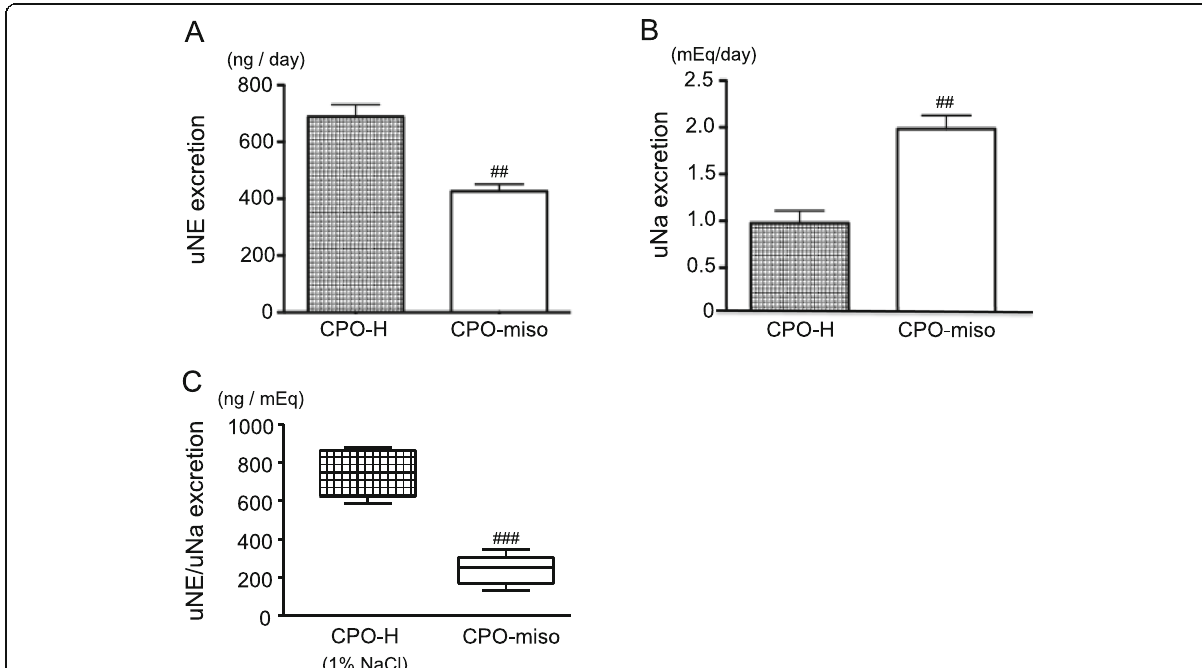
Fig. 2 a SNA evaluated on the basis of uNE excretion in each group. ## p = 0.001, CPO-H versus CPO-miso, n = 8 for each. Open bar graphs indicate CPO-miso; square-block bar graph indicates CPO-H. b Na intake in terms of uNa excretion in each group. ## p = 0.001, CPO-H versus CPO- miso, n = 8 for each. Open bar graphs indicate CPO-miso; square-block bar graph indicates CPO-H. c The ratio of uNE/uNa excretion, as a marker of SNA in response to salt intake. ### p < 0.001, CPO-H versus CPO-miso, n = 8 for each. Open bar graphs indicate CPO-miso; square-block bar graph indicates CPO-H. SNA, sympathetic nerve activity; CPO-H, chronic pressure overload mice with high salt water; CPO-miso, chronic pressure overload mice with miso soup; uNE, 24-h urinary norepinephrine; uNa, 24-h urinary